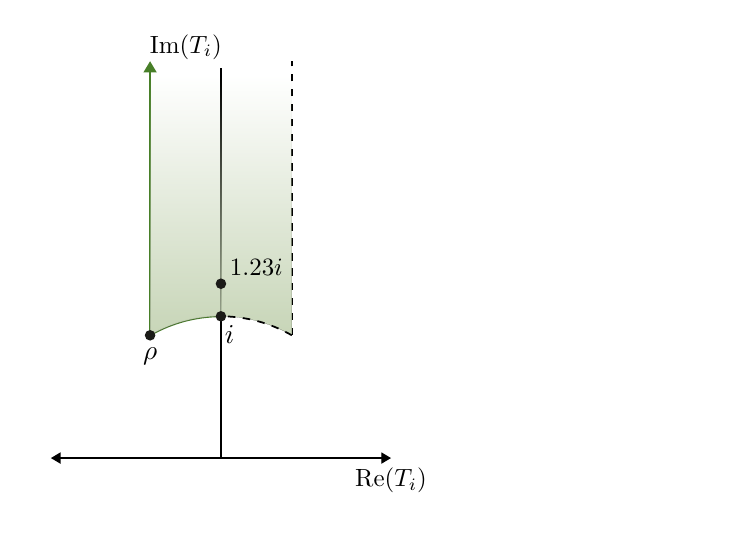
Figure 1 . The strict fundamental domain e F i of the diagonal Kähler modulus T i . The dots indicate the fixed points as well as the oft-quoted stabilized value T moduli